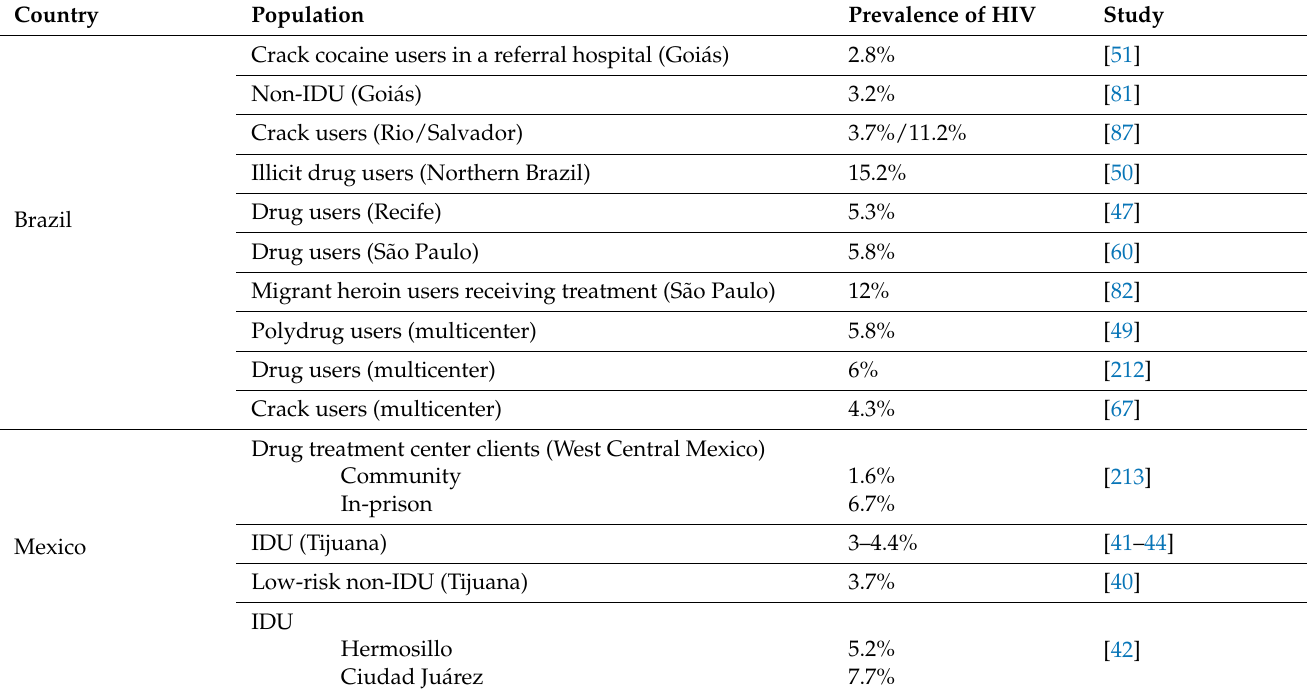
Table 3. Prevalence of HIV among people who use substances in Latin